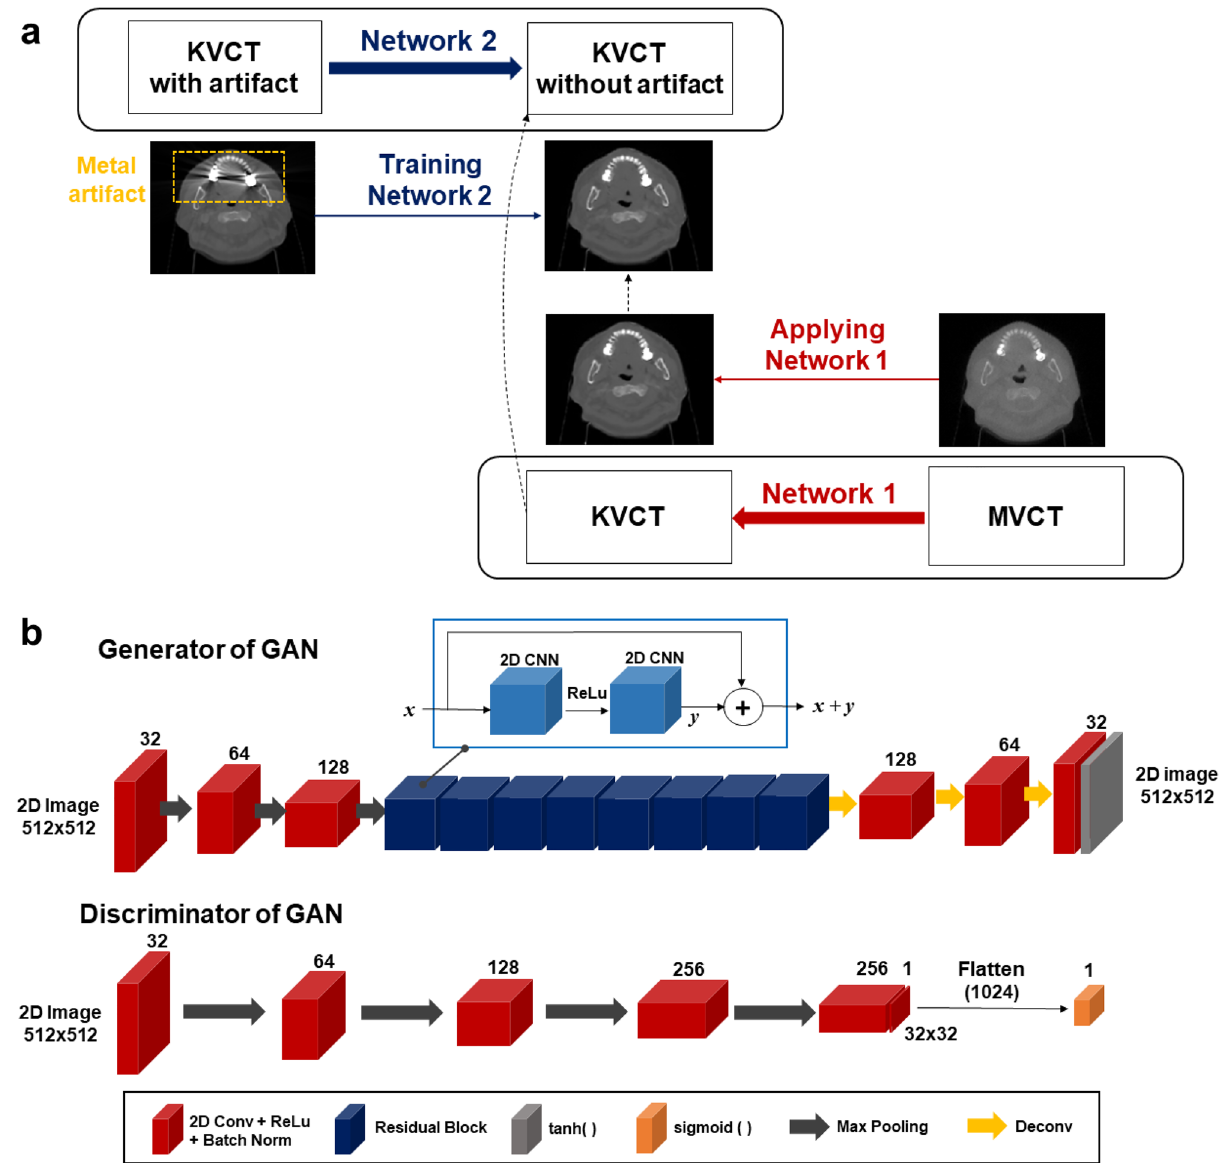
Figure 2. ( a ) Proposed MAR in kV CT images throughout Two-step sequential Network (MARTIAN), and ( b ) Network architectures of generator (with no skip connection) and discriminator used for